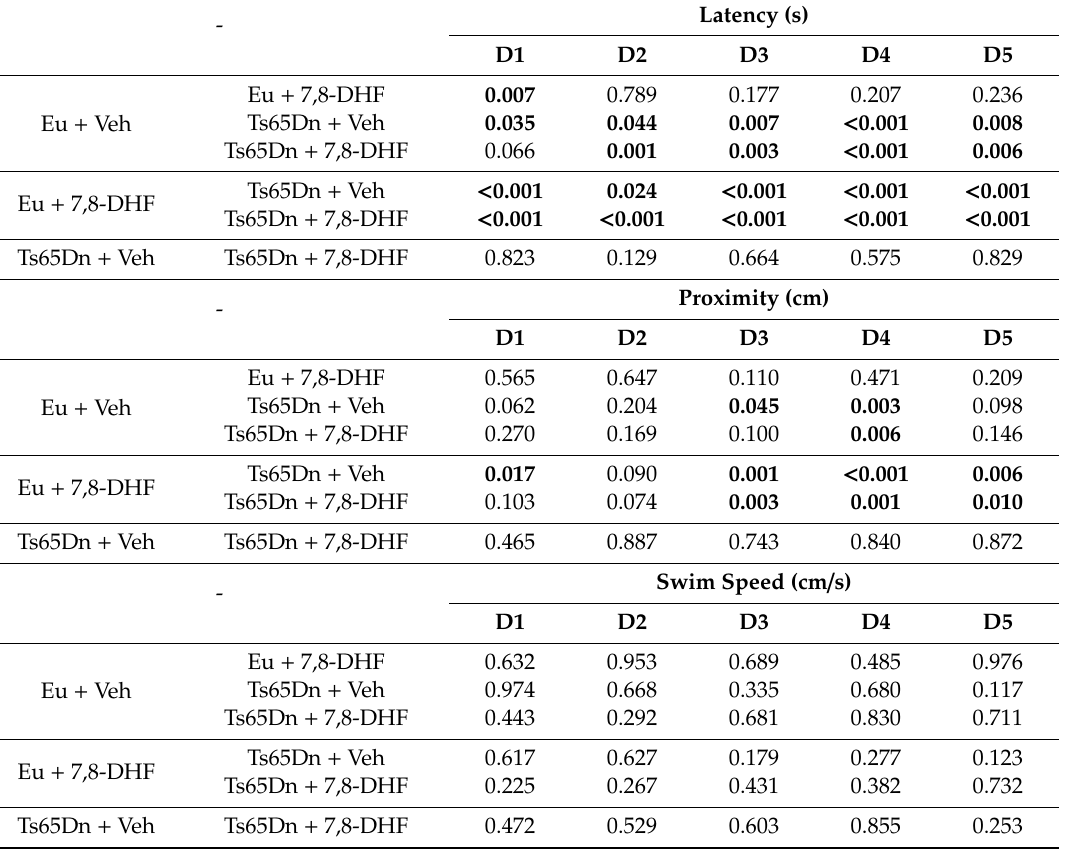
Table 1. p values of the Fisher LSD test for the indicated variables, during the learning phase of the MWM in euploid and Ts65Dn mice treated with vehicle or 7,8-DHF in the period